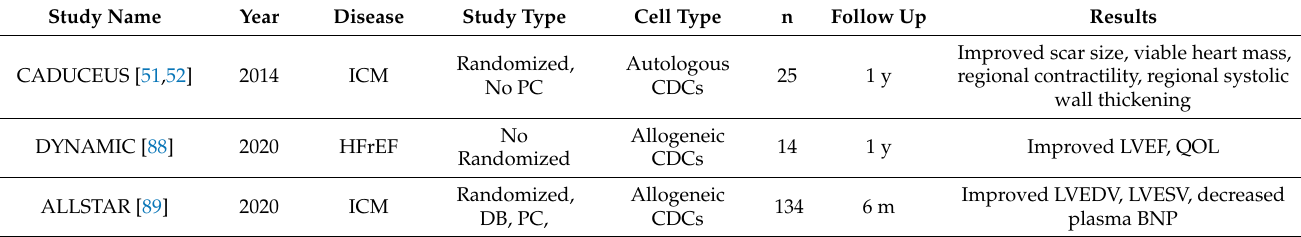
ICM: ischemic cardiomyopathy, HFrEF: heart failure with reduced ejection fraction, PC: positive control, DB: double blind, CDCs: cardiosphere-derived cells, LVEF: left ventricular ejection fraction, QOL: quality of life, LVEDV: left ventricular end-diastolic volume, LVESV: left ventricular end-systolic